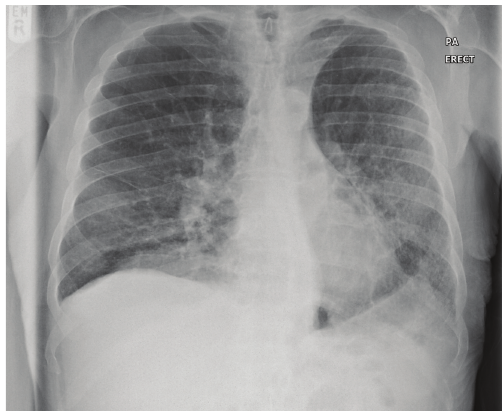
Figure 1: Chest X-ray on day one of admission. Figure 2: Chest X-ray on day two of